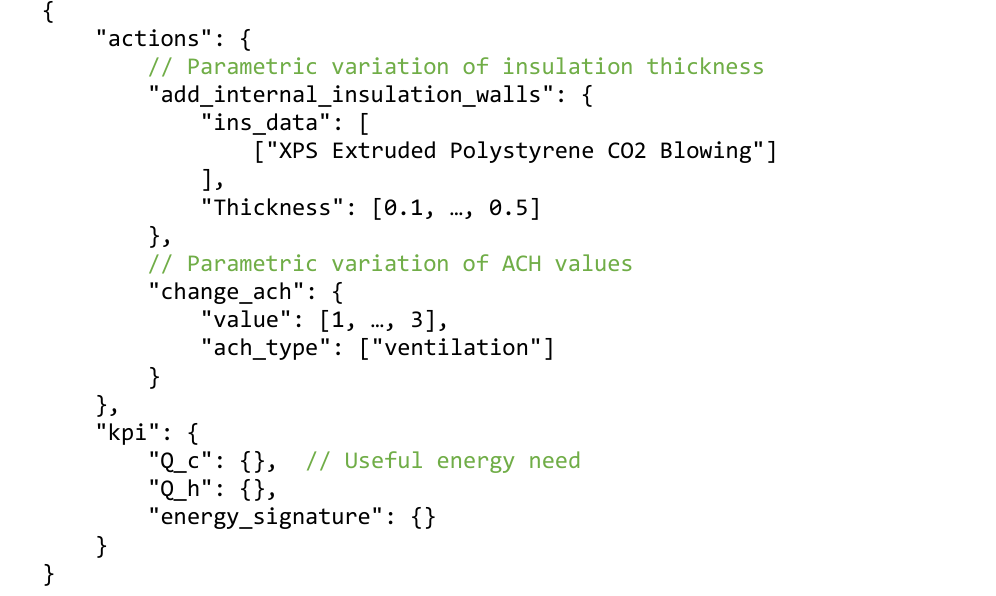
Algorithm 1. Example of an input *.json file to feed